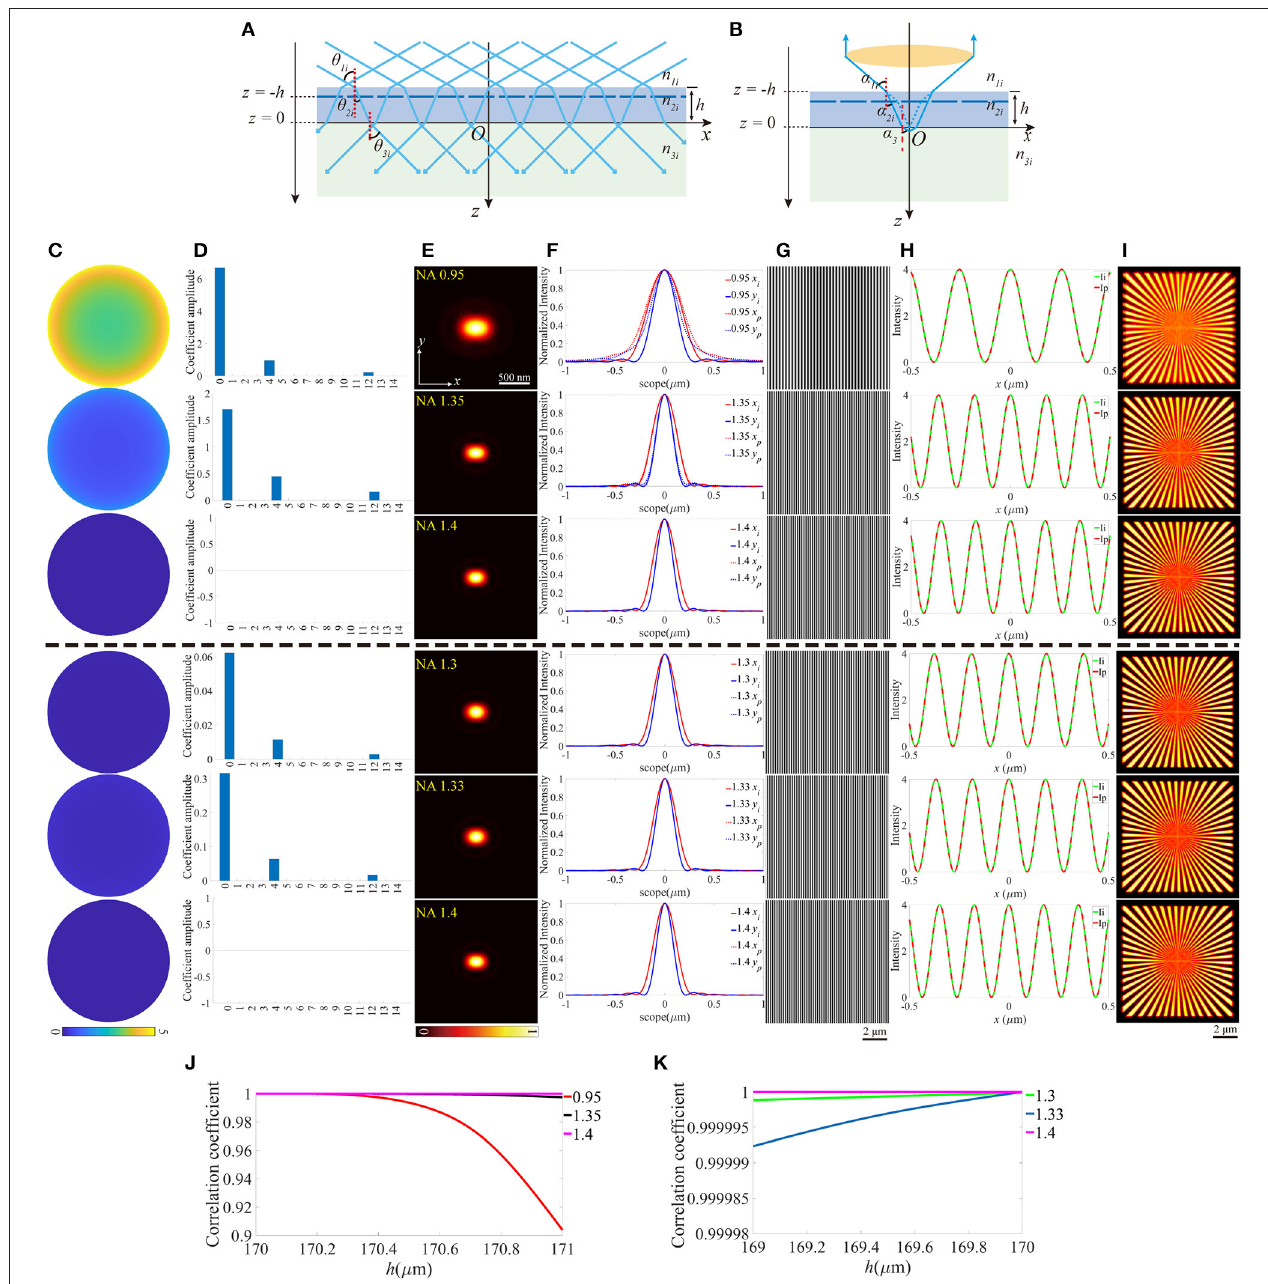
FIGURE 4 | The aberrations induced by the deviation of the thickness of the coverslip. (A,B) The thickness of the coverslip has a biased value for the illumination path and the detection path. (C) The pupil functions calculated from the case depicted in (B) . (D) Zernike decomposition of the pupil functions shown in (C) . (E) The PSFs on the plane z = 0, calculated from the corresponding pupil functions. (F) The profiles of the ideal and biased PSFs in (E) . (G) The excitation patterns affected by the biased h . (H) The local profiles of the corresponding excitation patterns shown in (G) , the scope is − 0.5 ∼ 0.5 µ m. (I) The corresponding reconstructed images of SIM. (J,K) The correlation coefficients of SIM images with different h for n 1 ≤ n 2 and n 1 ≥ n 2 ,